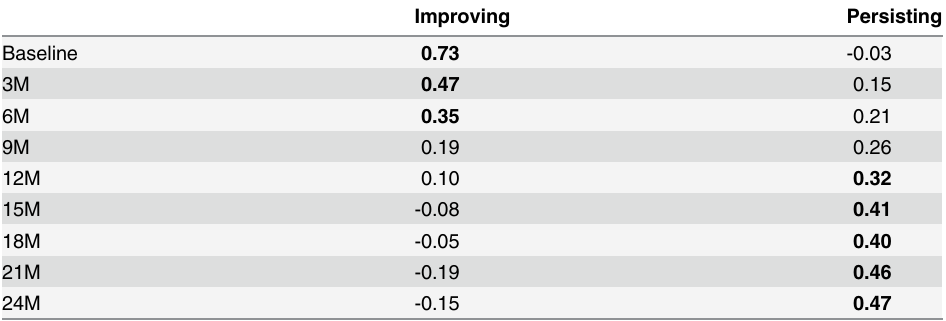
Table 3. The time-mode component scores averaged across 20 imputed datasets. Standard deviations (computed across 20 imputed datasets) were at most 0.03 across all loadings. The time-mode component scores (cid:1) 0.30 are printed in bold font.